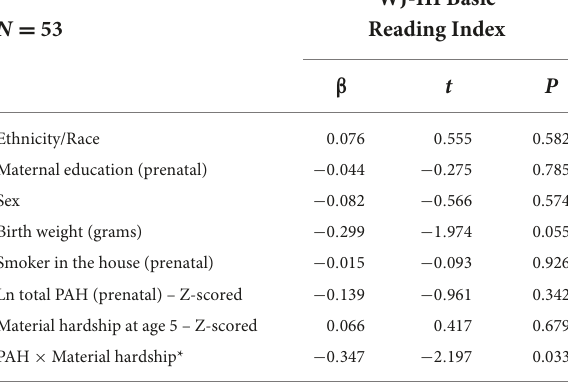
TABLE 3 Regression analyses predicting WJ-III Basic Reading